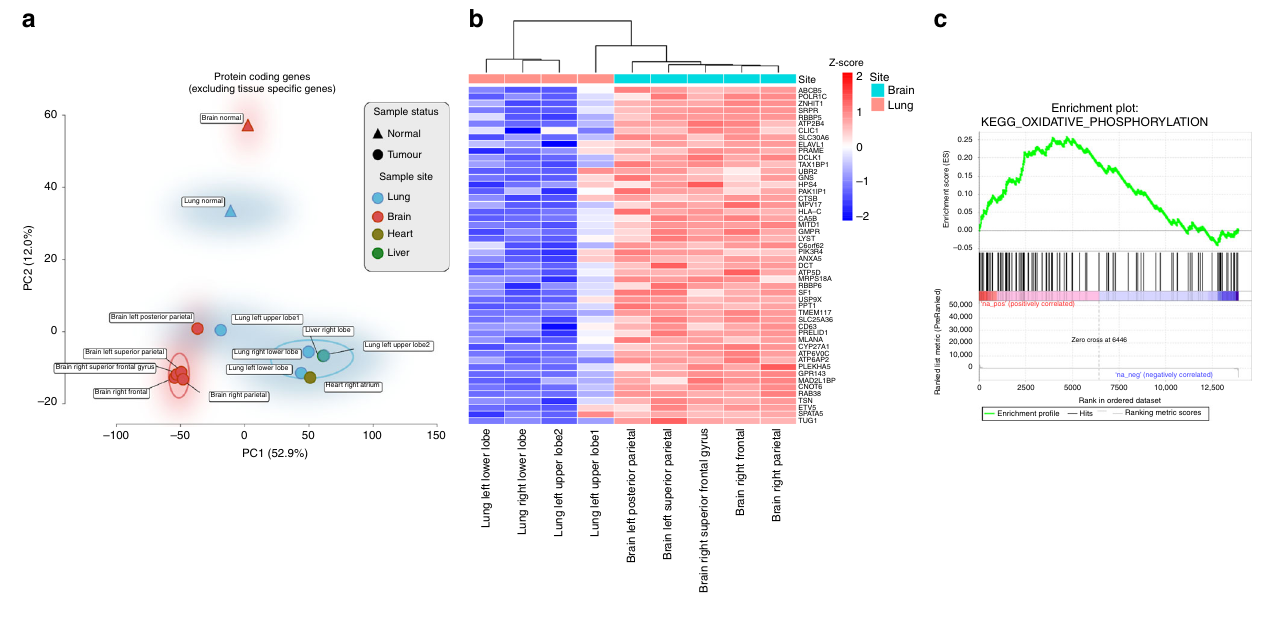
Fig. 4 Gene expression analyses reveals regional separation of site-speci fi c metastases. a Principal component analysis of protein-coding gene expression across all samples. A regional separation can be seen between the brain ( n = 5, coloured red circles) and lung metastases ( n = 4, coloured blue circles) on PC1 along the x -axis (these samples are circled using a kernel density estimation), which accounted for greater variance than the separation between the tumour ( n = 11) and normal samples ( n = 2) by PC2 along the y -axis (53% vs. 12%, respectively), indicating that expression patterns are at least partially in fl uenced by cellular contamination from the surrounding stromal cells. b Heatmap showing the top 50 intersecting genes that are differentially expressed between both brain vs. lung metastases and brain metastases vs. normal tissue comparisons (see “ Methods ” section). Z -score scale indicates normalised gene expression and represents the number of standard deviations away from the mean (red-blue denoting high-low normalised gene expression, respectively). c Pre-ranked gene set enrichment analysis of genes associated with metastases to the brain revealed biological pathways that might have been implicated in brain metastases. The enrichment plot provides a graphical view of the enrichment score for a gene set. The top portion of the plot shows the running enrichment score for the gene set as the analysis walks down the ranked list. The middle portion of the plot shows where the members of the gene set appear in the ranked list of genes and the bottom portion of the plot shows the value of the ranking metric as you move down the list of ranked genes. Oxidative phosphorylation was the most statistically signi fi cant over expressed MSigDB KEGG pathway, enriched in both the brain vs. normal tissue and brain vs. lung comparisons (FDR corrected p -value < 0.0001, calculated by constructing a histogram corresponding to null enrichment scores see ‘ Methods ’ section), and has recently been linked to melanoma brain metastases in both human and murine analyses 35 .